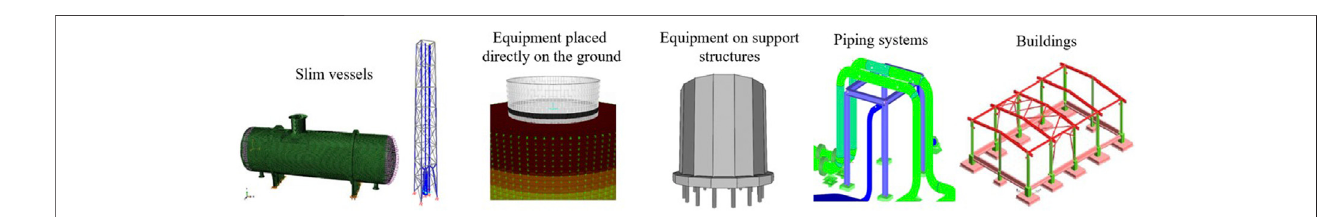
FIGURE 2 | Structural typologies of a process